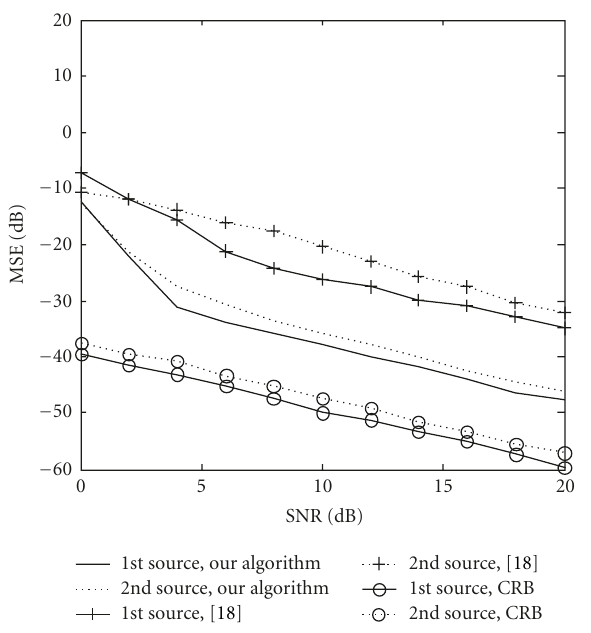
Figure 3: Estimation MSE of the azimuths versus input SNR.